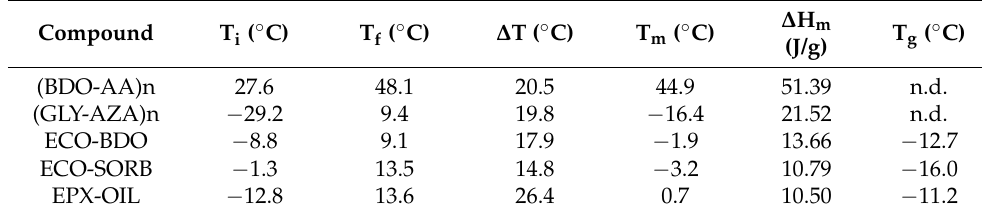
Table 5. DSC parameters of the oligoesters and plasticizers.